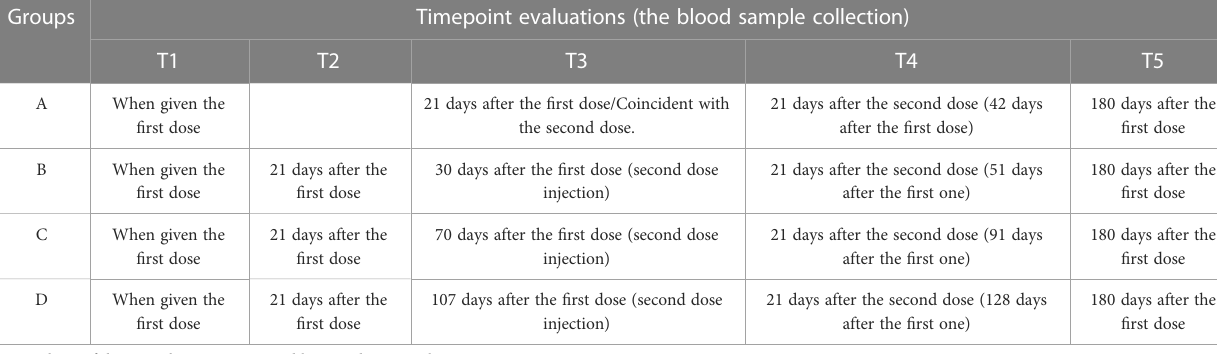
TABLE 1 A summary of the study groups in terms of vaccination and antibody assessments.